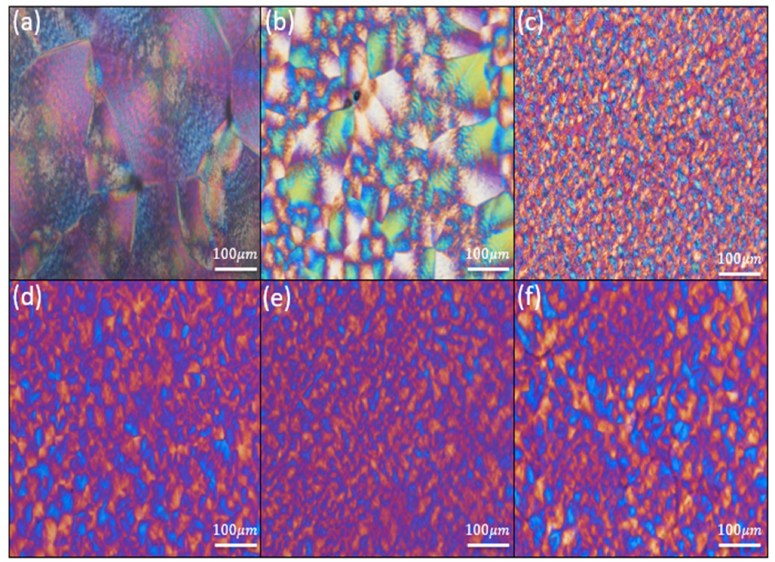
Figure 7. Polarized optical micrographs for PA56/66 copolyamides annealed at 300 ◦ C for 5 min and slow-cooled off of ( a ) PA56, ( b ) CoPA-1, ( c ) CoPA-2, ( d ) CoPA-3, ( e ) CoPA-4 and ( f )